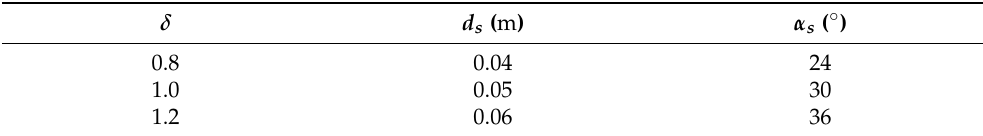
Figure 2. The two example movements of a mobile robot in visual reward functions: left to right ( a ) and right to left ( b ). Table 2. The vicinity threshold values of distance d s and orientation α s